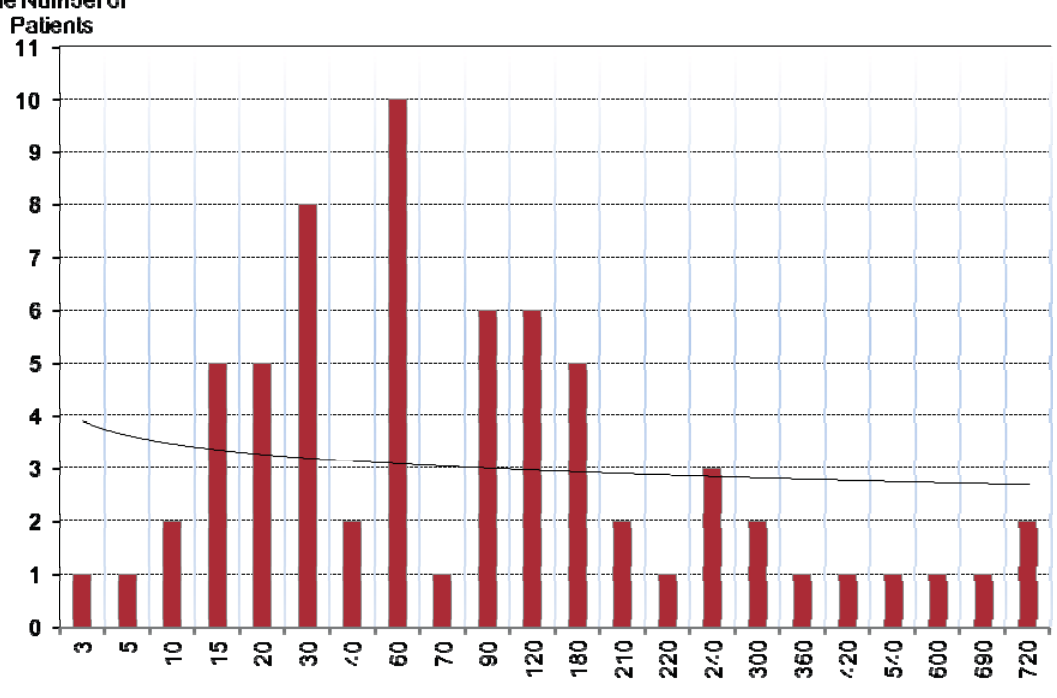
Figure 5. The time dependent on the patient—from the beginning of the chest pain until medical help. Time of providing medical help (depending on the patient) ranges from 3 to 720 min. The average time was 140